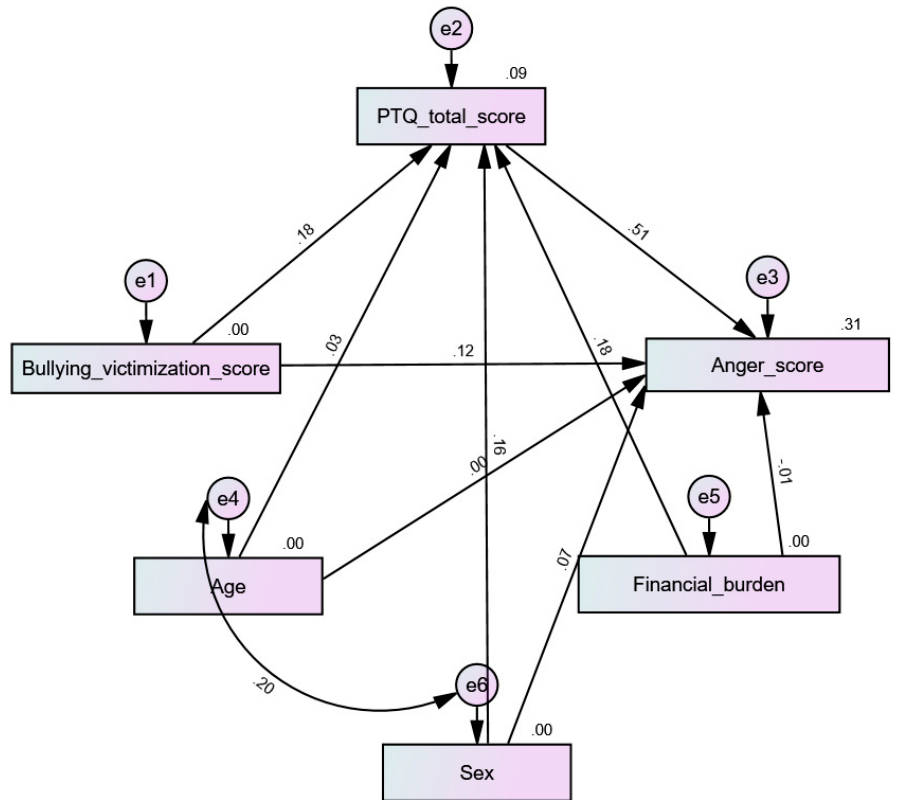
Figure 5. Path analysis model with hostility as the dependent variable.